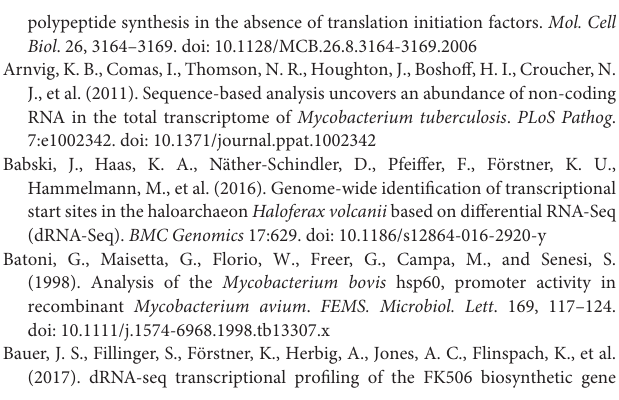
Table S6 | Genome-wide operon (sub-operon) identificaiton. Table S7 | Expression profiles of genes selected to screen high activity